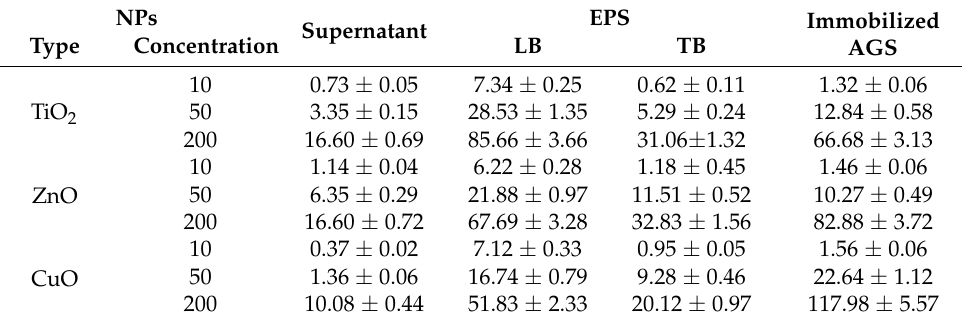
Table 1. The fate of different dosages of NPs in supernatant and AGS a